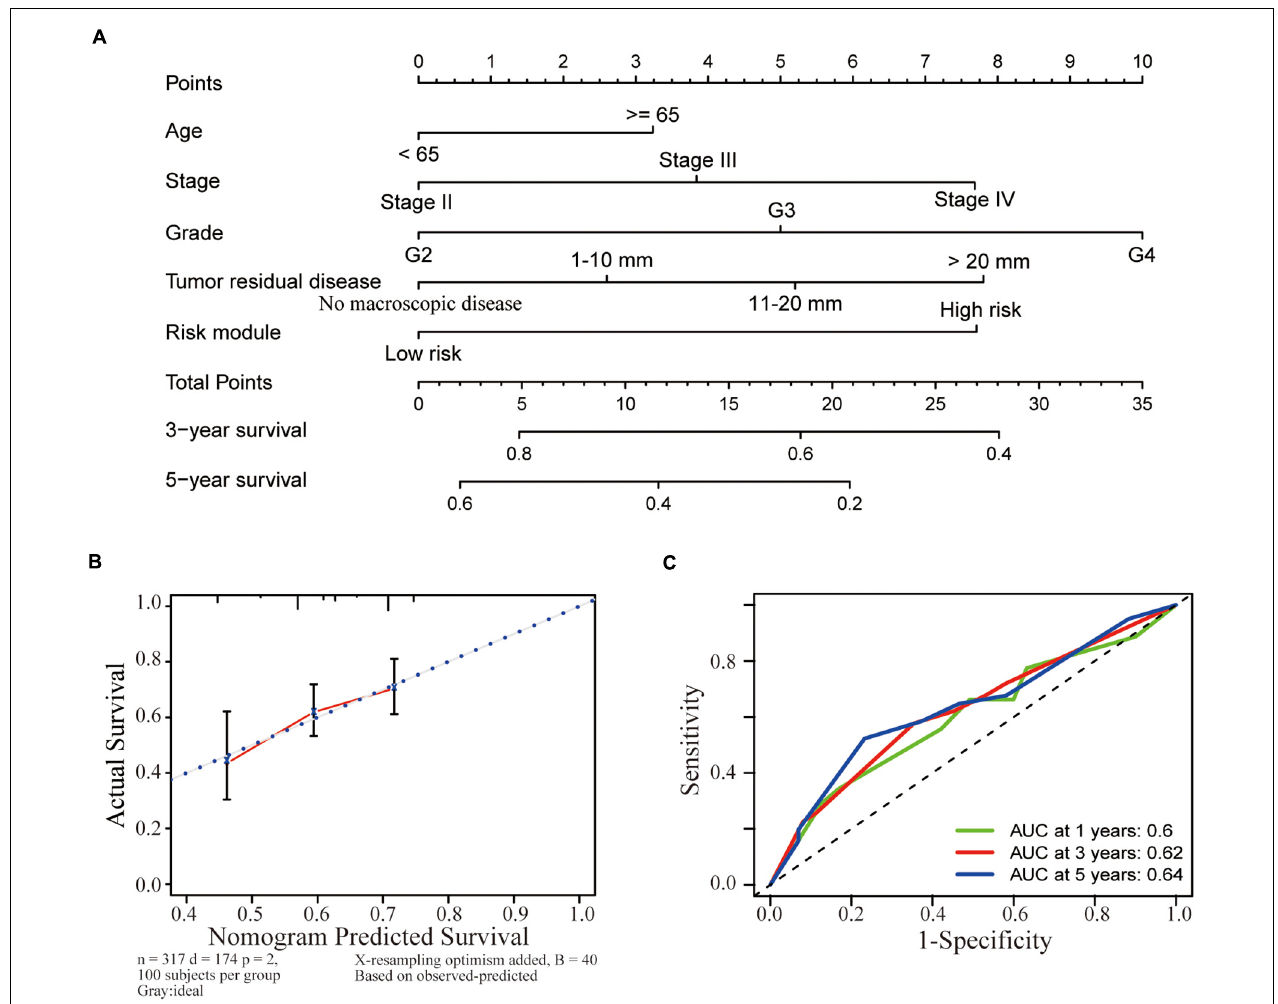
FIGURE 5 | Establishment of a nomogram based on clinicopathological characteristics, including the risk model. (A) A nomogram was established to identify the relationship between the survival time and clinicopathological characteristics (including age, stage, grade, residual tumor disease, and risk model). The survival probability of patients with OC at 3 and 5 years was estimated by calculating the total points corresponding to the nomogram. (B) The nomogram had favorable predictive power for the 3-year and 5-year survival of patients with OC. (C) A ROC curve analysis was conducted to determine the accuracy of the prediction obtained from the risk score model. The calculation of the area under the curve (AUC) was 0.6 for 1 year, 0.62 for 3 years, and 0.64 for 5